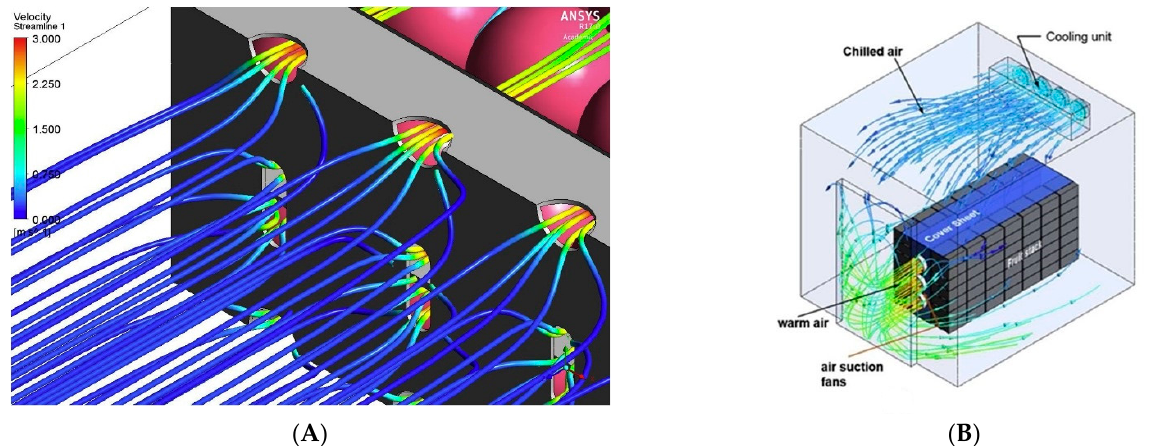
Figure 5. Airflow across vent holes of a standard corrugated fiberboard packaging ( A ) and forced- air-cooling tunnel ( B ) (Reprinted with permission from [25], Copyright Elsevier (2020)). cooling tunnel ( B ) (Reprinted with permission from [25], Copyright Elsevier